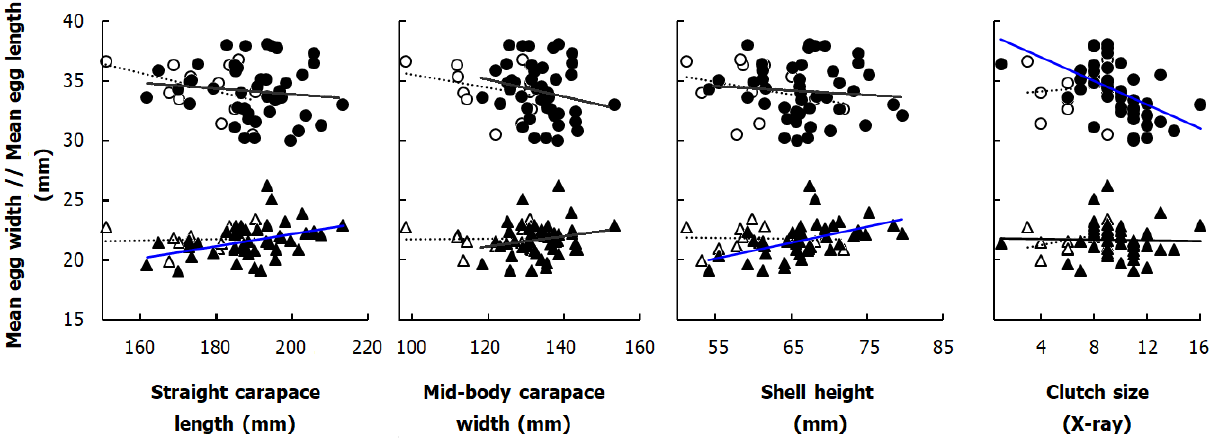
Figure 5. Linear regressions between both mean length (circles) and width (triangles) of eggs and three body size measurements in addition to the clutch size of Mauremys leprosa from the two studied populations (X-ray technique). The solid trendlines associated with the black-colored shapes represent the data of the Boukhmira population, while the dotted trendlines associated with the open shapes represent the data of Lake Tonga. Significant regression lines (in blue) are from the left, respectively: Mean EW = 12.11 + 0.05 SCL (R-Sq = 15.9%); Mean EW = 12.90 + 0.13 SH (R-Sq = 25.4%); Mean EL = 38.98 − 0.50 Rad-Clutch (R-Sq = 28.4%) .